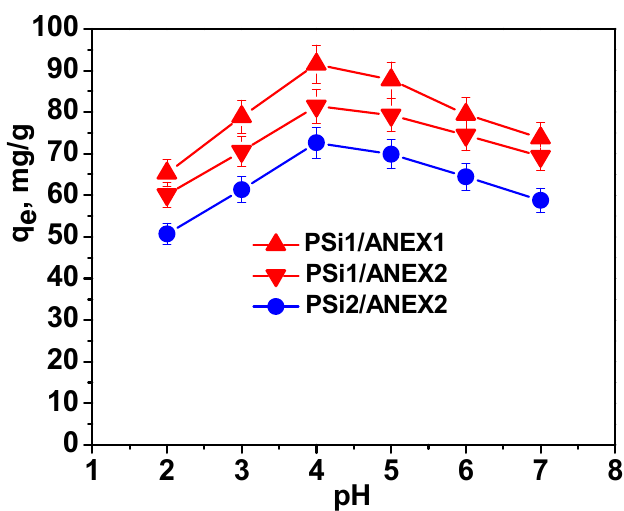
Figure 5. E ff ect of pH on the sorption capacity (q e ) of the SiO 2 / ANEX composite sorbents for Cr(VI) Figure 5. Effect of pH on the sorption capacity (q e ) of the SiO 2 /ANEX composite sorbents for Cr(VI) oxyanions: sorbent dose 1 g / L; temp. 23 ◦ C; contact time 6 h; shaking rate 180 oxyanions: sorbent dose 1 g/L; temp. 23 °C; contact time 6 h; shaking rate 180 r.p.m.